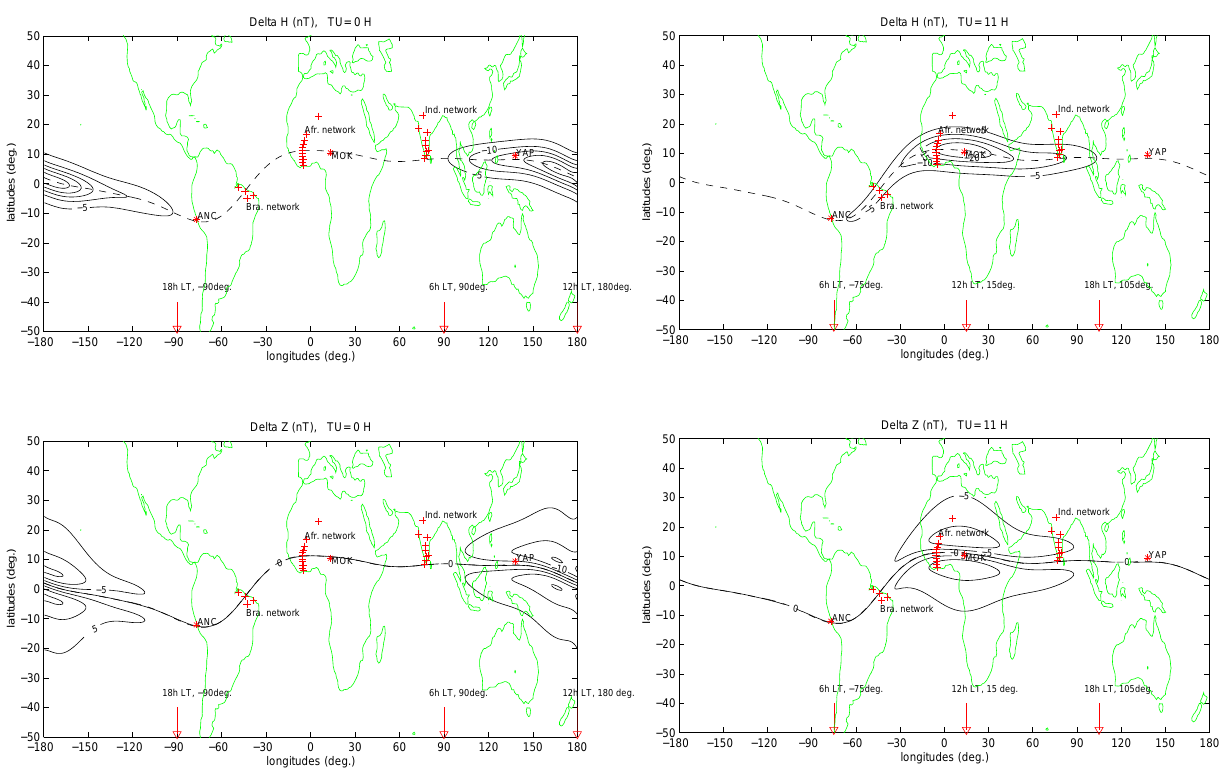
Fig. 5. ( a ) A snapshot of the H and Z components of the EEJ model magnetic signature at a fixed universal time (00:00 UT) and an altitude of 450km. The CHAMP satellite mean longitudinal variation was used to compute the EEJ magnetic signature at CHAMP altitude and epoch. 1H contour interval is 5nT for a minimum of about − 30nT, 1Z contour interval is 5nT with a minimum of − 15nT and a maximum of 15nT. The dashed line represents the